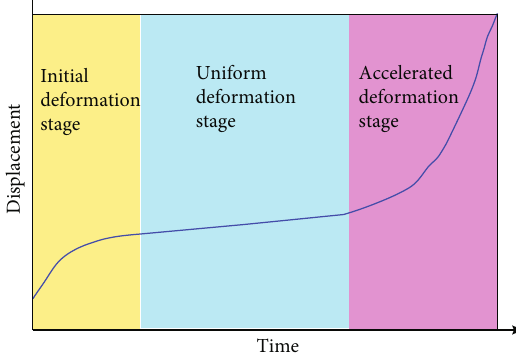
σ ∞ is the long-term strength, and